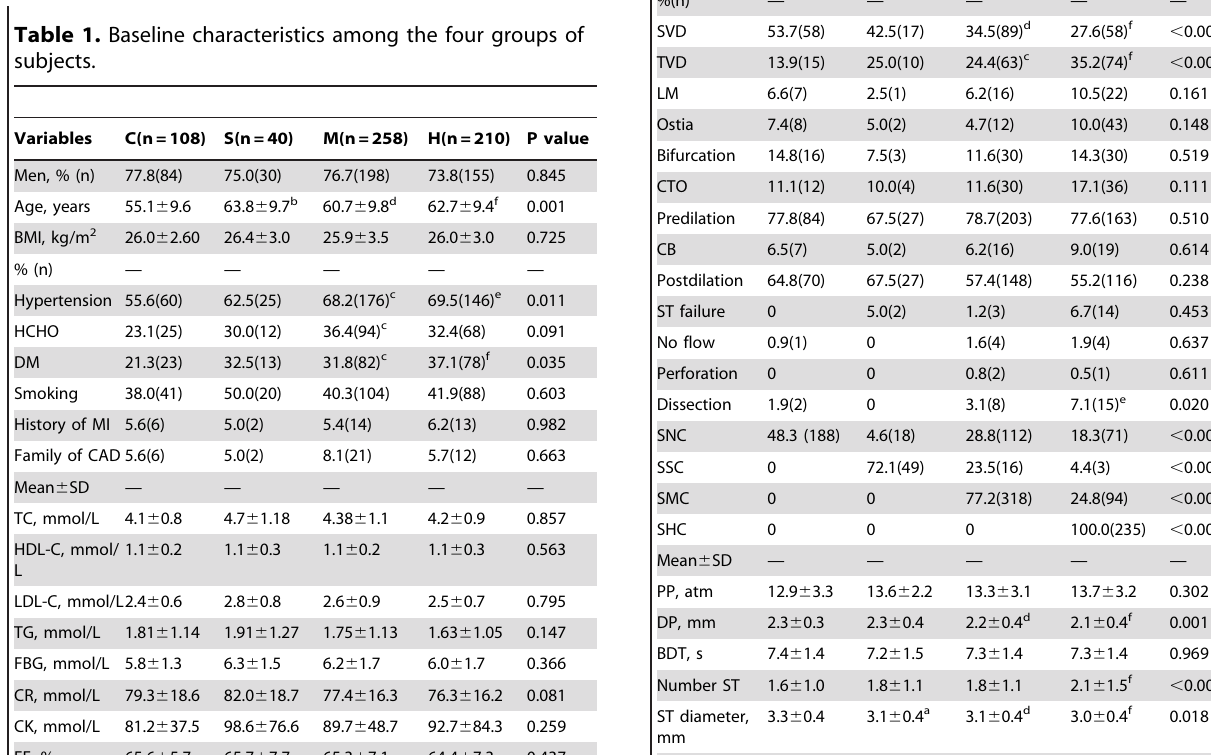
Table 1. Baseline characteristics among the four groups of subjects.